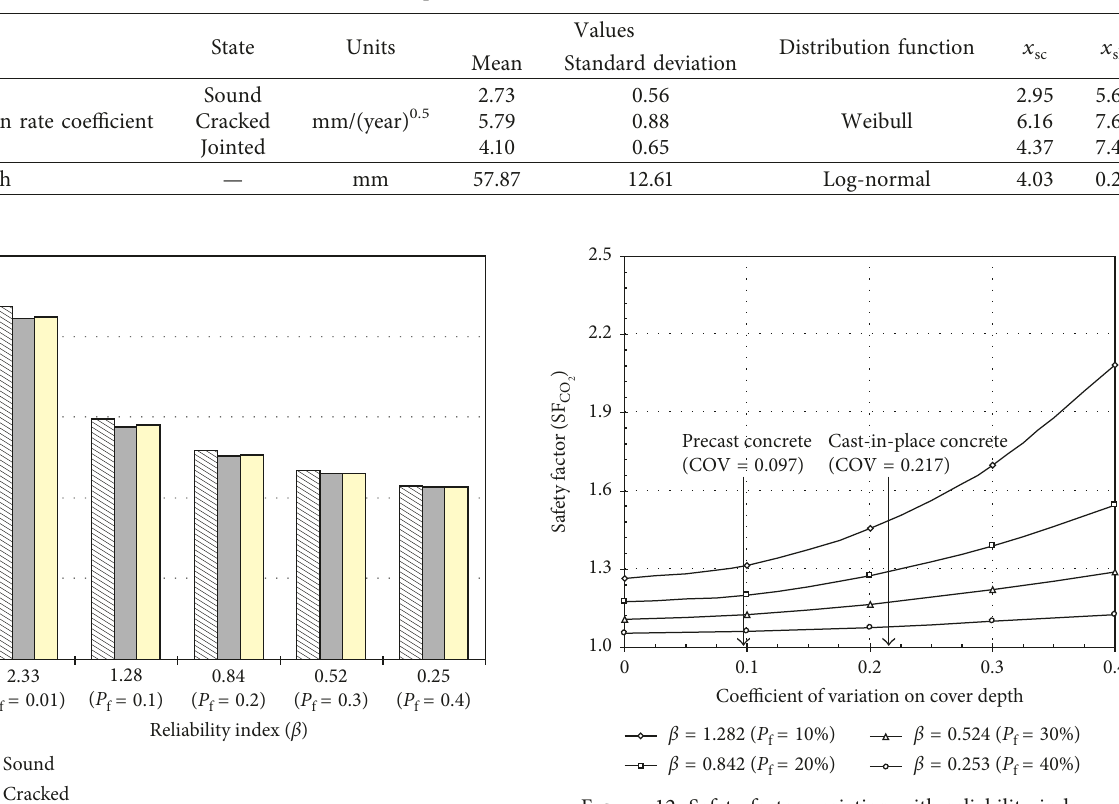
Table 2: Stochastic parameters for Monte Carlo simulation.